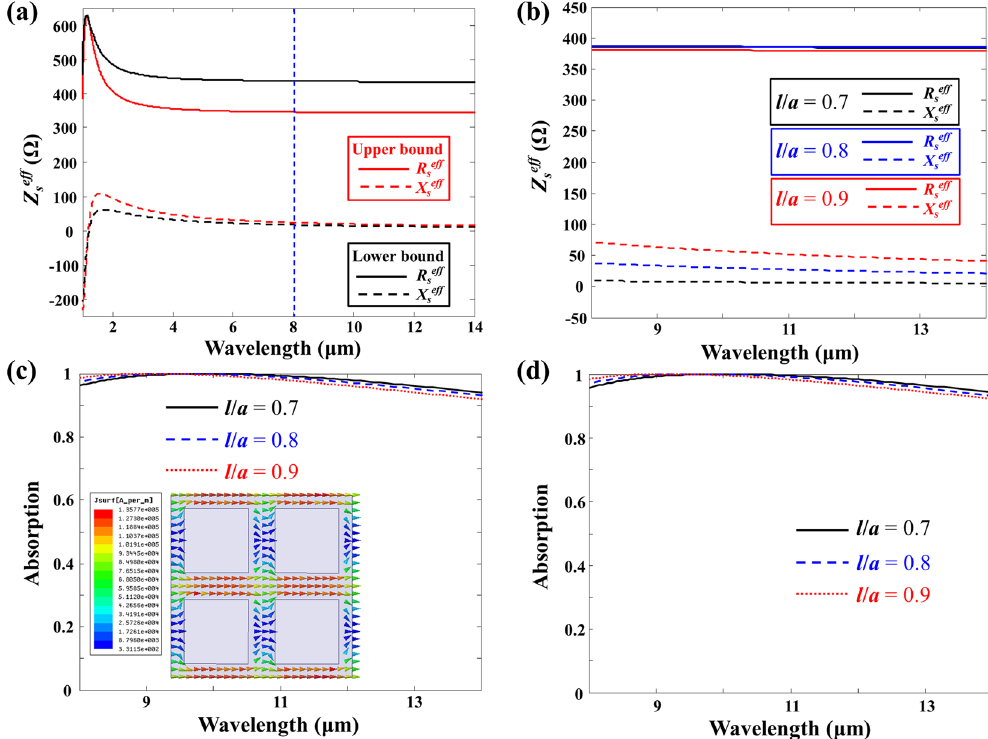
Figure 3. ( a ) Retrieved effective surface impedances of the metasurfaces for both the upper bound (red curves) and lower bound (black curves) cases. ( b ) Retrieved effective surface impedances of the metasurfaces for l = 0.7 μ m with R s = 128 Ω (black curves), l = 0.8 μ m with R s = 83 Ω (blue curves), and 0.9 μ m with R s = 40 Ω (red curves). ( c ) Calculated absorption spectral responses of the metasurface absorbers for l = 0.7 μ m with R s = 128 Ω (black curves), l = 0.8 μ m with R s = 83 Ω (blue curves), and 0.9 μ m with R s = 40 Ω (red curves) with identical vacuum gap distances of d = 2.5 μ m. The inset shows the simulated surface current density distribution on the metasurface with l = 0.7 μ m at the resonance wavelength. ( d ) Simulated absorption spectral responses of the metasurface absorbers for l = 0.7 μ m with R s = 128 Ω (black curves), l = 0.8 μ m with R s = 83 Ω (blue curves), and 0.9 μ m with R s = 40 Ω (red curves) with identical vacuum gap distances of d = 2.5 μ